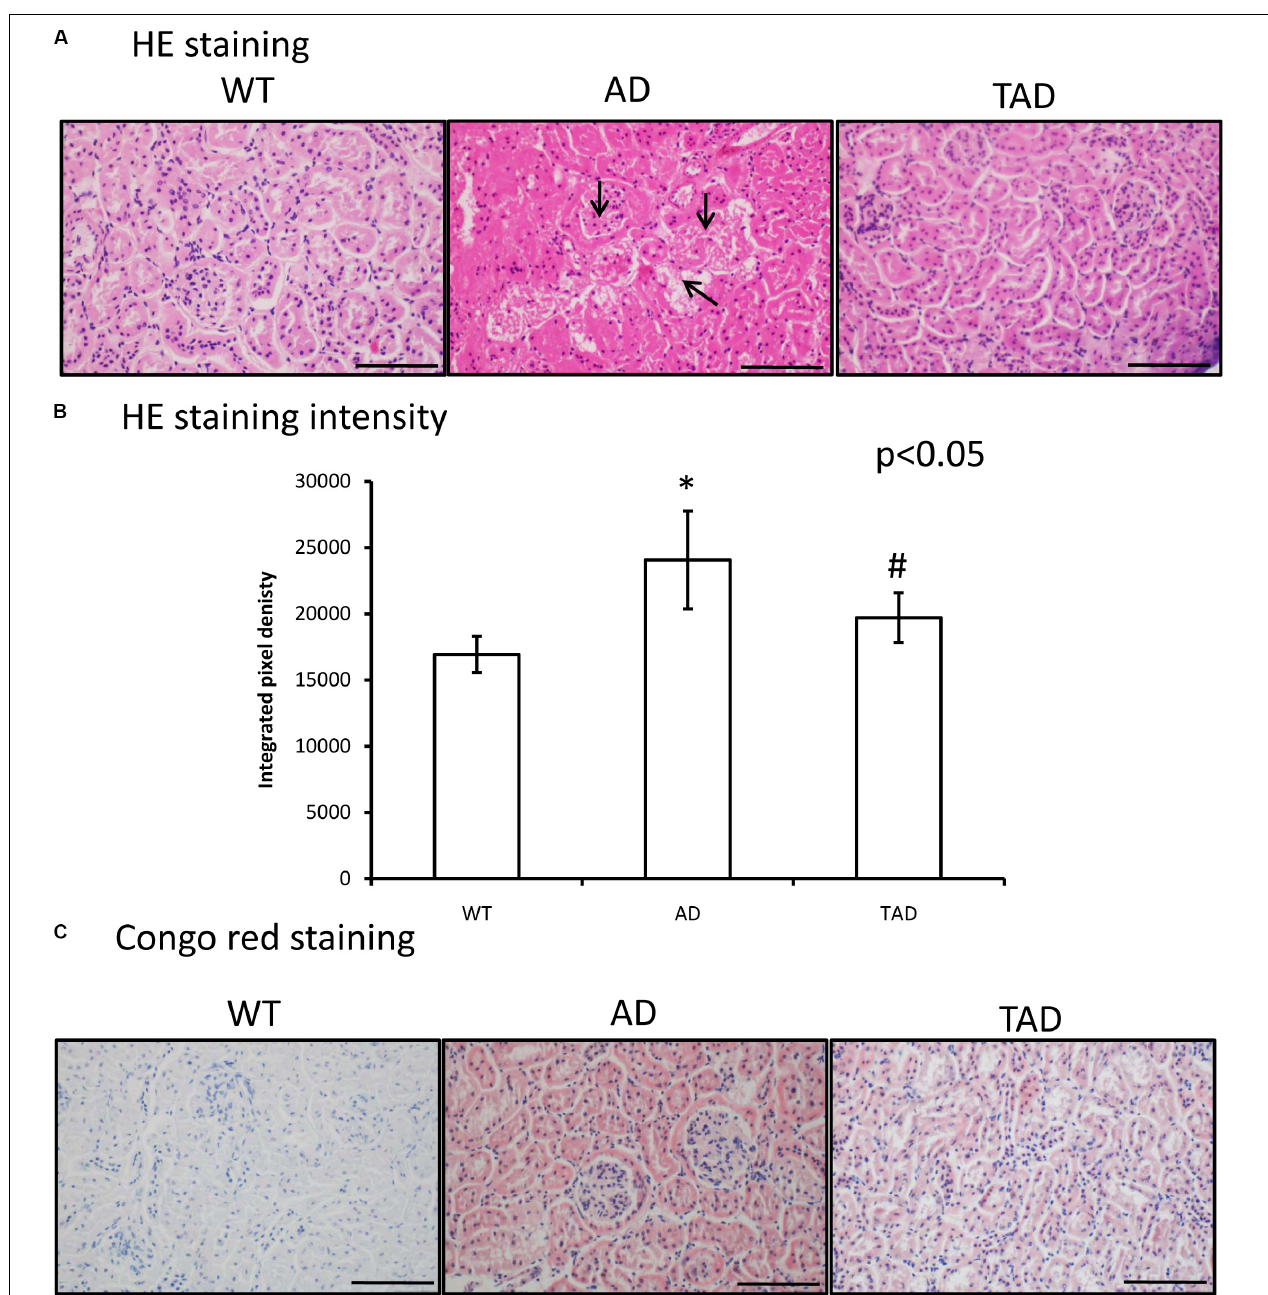
FIGURE 1 | (A) Representative microphotograph of wild-type (WT), Alzheimer’s disease (AD), and trained Alzheimer’s disease (TAD) kidneys stained with hematoxylin and eosin. Overview of the kidney cortex. Original magnification was × 20. Scale bar , 50 µ m. Arrows show a representative area for amyloid beta (A β ) plaque formation. (B) Staining intensity analysis. Representative data of five independent experiments. The staining intensities are presented as bar graphs ± SEM. Asterisks indicate significant ( ∗ p < 0.05) differences in the staining pixel intensity compared to WT and ( # p < 0.05) compared to AD. (C) Representative microphotographs of WT, AD, and TAD kidneys stained with Congo red. Red colors show A β accumulation. Original magnification was × 20. Scale bar , 50 µ